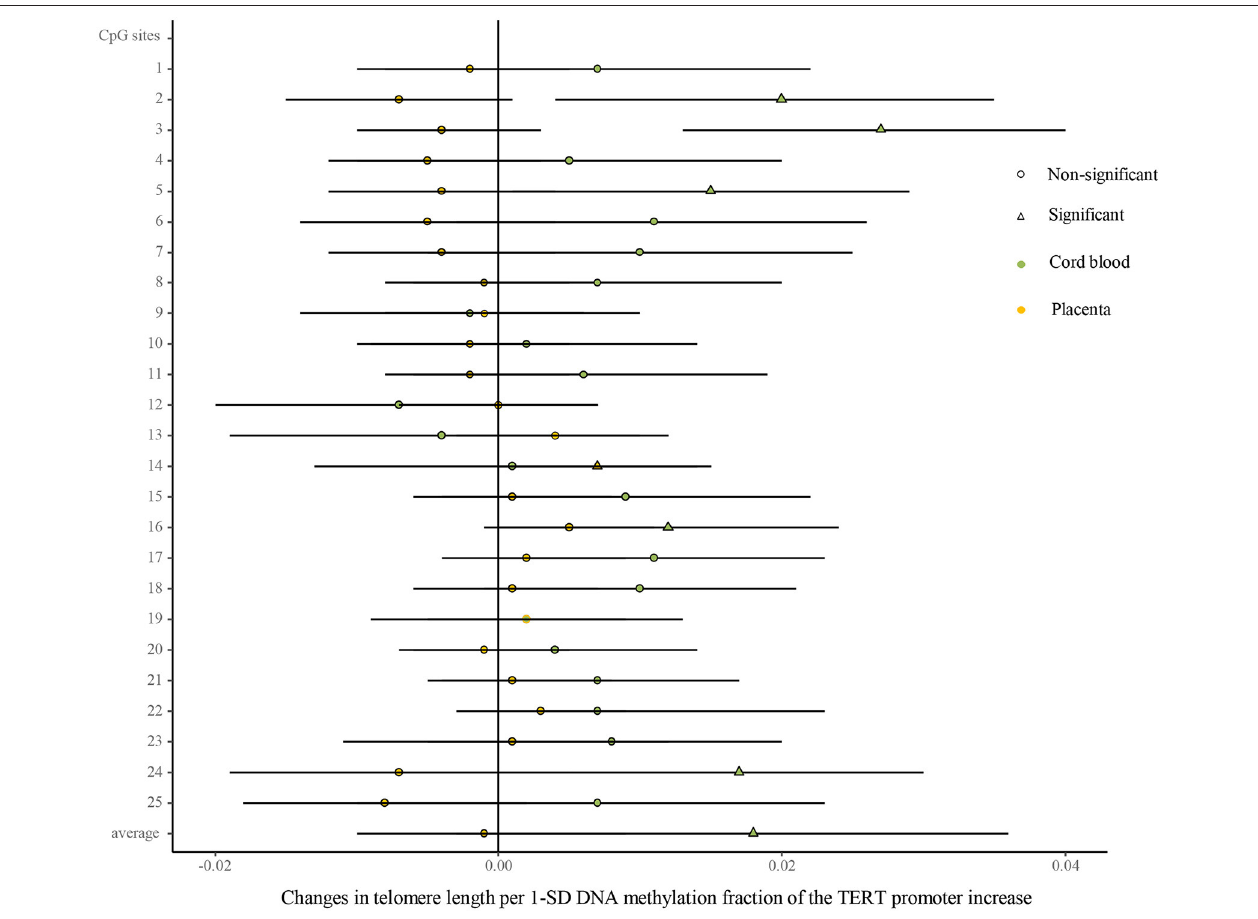
FIGURE 5 | Differences in the associations of methylation fractions of CpG sites in the TERT promoter and TL between the cord blood and the placenta. The continuous model is used to include the SD score as continuous DNA methylation fractions of the TERT promoter, where DNA methylation fractions are independent variables and TL are dependent variables. β -coefficients and 95% CI are adjusted for gestational age at birth, infant sex, birth weight and length, and maternal age, maternal prepregnancy BMI, and gestational weight gain, and paternal age and BMI, and represent changes in TL in the cord blood and the placenta with 1-SD increase in methylation fractions of CpG sites of the TERT promoter. Circle: non-significant; triangle: significant; color green: the cord blood; color yellow: the